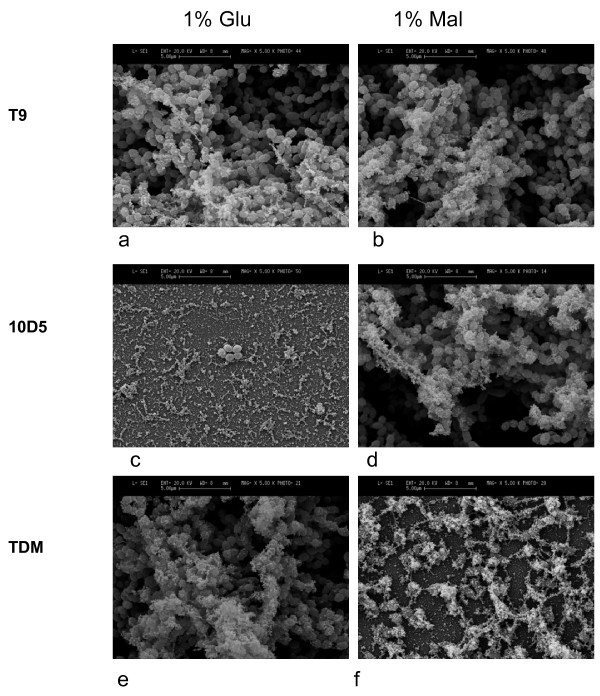
Scanning electron micrographs of the wild-type and the two mutants grown in 1% maltose or 1% glucose. The wild-type formed a well-organized, multilayered biofilm in all growth conditions. The transposon mutant formed biofilm only in maltose while the triple deletion mutant exhibited a well-formed biofilm in glucose. Maltose induced the formation of amorphous material covering the cells. Biofilm in glucose and maltose was different: wild-type bacteria grown in glucose showed small aggregates on the cell surface and these aggregates became larger and less regular when bacteria were grown in maltose. These larger aggregates where also present on the surface of the transposon mutant when grown in maltose and on the deletion mutant grown in glucose.